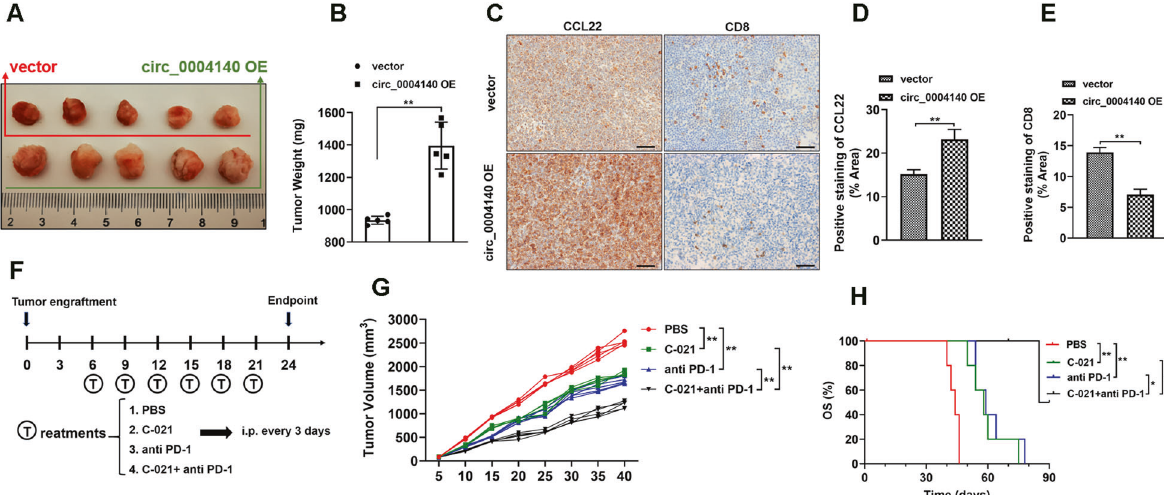
Fig. 6 circ_0004140 is related to cytotoxic T lymphocyte exhaustion and immunotherapy effect in vivo. The morphology of the tumor xenografts ( A ) and the weight ( B ) of xenograft tumors formed by subcutaneous injection of LUAD cells stably transfected with circ_0004140 overexpression lentiviruses or control vector ( n = 5). C – E IHC staining was utilized to detect the CCL22 expression ( C , D ) and CTL numbers ( C , E ) in xenograft tumor tissues ( n = 3). Scale bar = 100 μ m. F Schematic illustration of xenograft tumor treatment. Tumor-bearing mice were treated on indicated days with C-021 (CCL22 inhibitor), or anti-PD-1, or combination administration ( n = 5). G Tumor growth was monitored through measuring tumor volume ( n = 5). H Kaplan – Meier survival curve of C-021 or anti-PD1 or combination-treated xenograft mice ( n = 5).